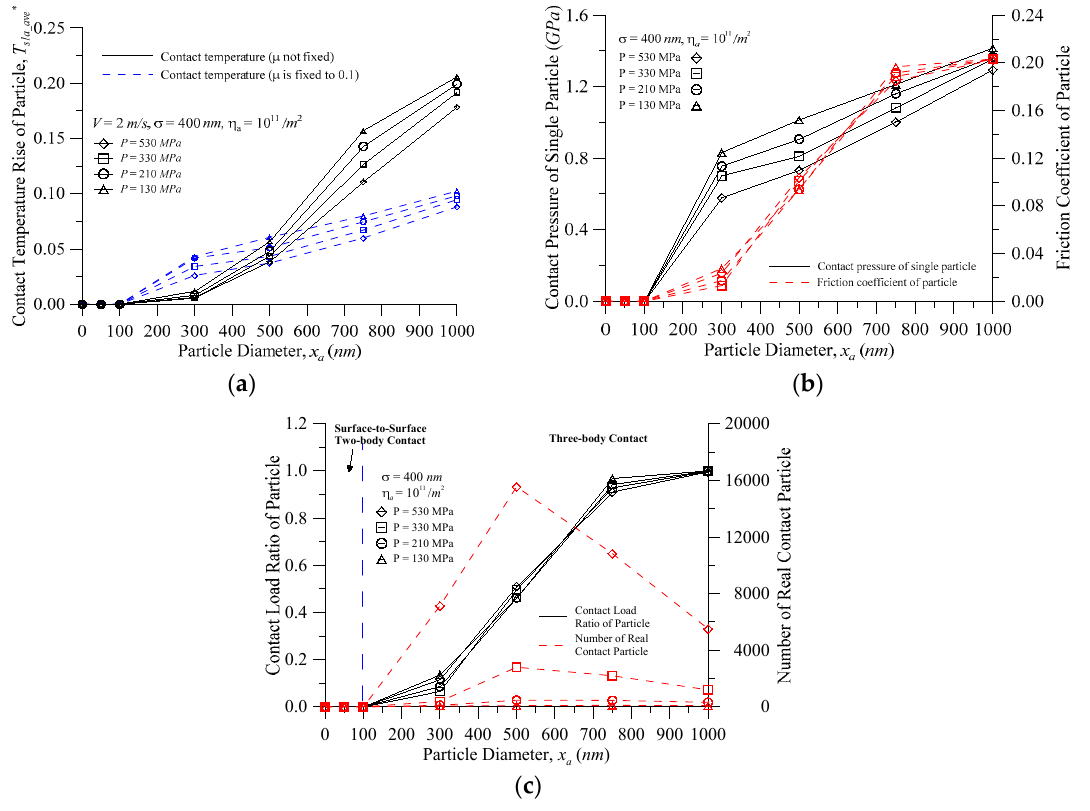
Figure 4. The characteristics of the particle vs. the particle diameter at various contact pressures for ( a ) the contact temperature rise; ( b ) the contact pressure of a single particle and the coefficient of friction; and ( c ) the contact load ratio and the real contact number.